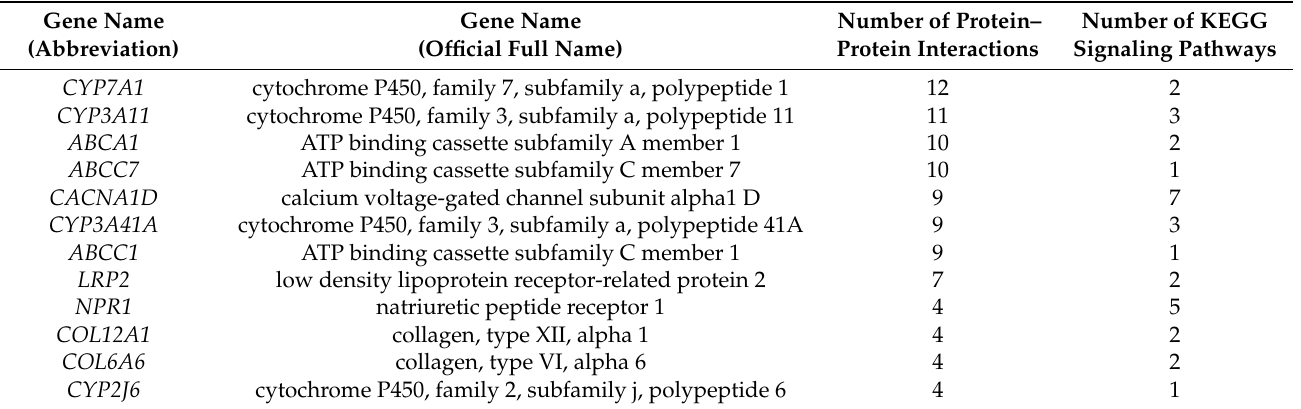
Figure 6. The PPI network. The dots stand for proteins, and the connection represents the interaction between genes. Table 2. Summary of key DEGs.